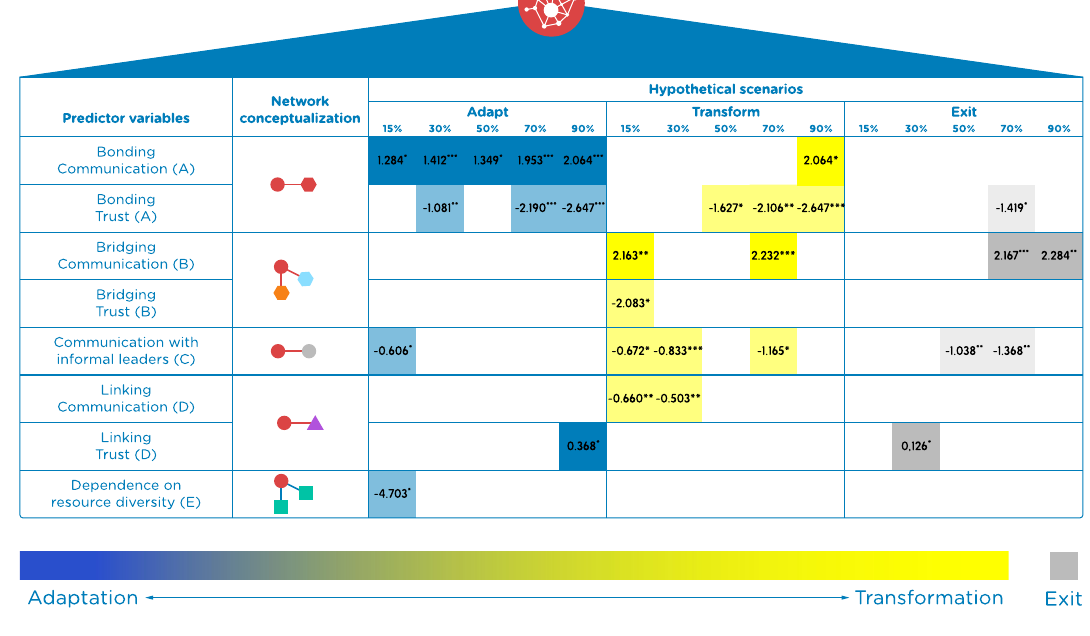
Figure 4. The role of social and social-ecological network structures on responses to incremental climate change impact scenarios. Significant results ( P < 0.1) from five multinomial multilevel logit mixed-effects models on each climate change hypothetical scenario (− 15%, − 30%, − 50%, − 70%, − 90% in fisheries income). Names and letters of network structures are akin to Fig. 1 and Table 1. Blue, yellow, and grey indicate adaptation, transformation, and exit responses, respectively. Remaining in the fishery—the business-as-usual option—was set as the base category. Brighter colours indicate positive ( +) relationships whereas lighter colours indicate negative (−) relationships. All models controlled for other aspects (i.e., domains) of adaptive capacity; such as assets, agency, learning, flexibility, socio-cognitive factors, and other competing concerns; see Supplementary Table S3 for a description of all covariates included. Full results of the five models are available in Supplementary Tables